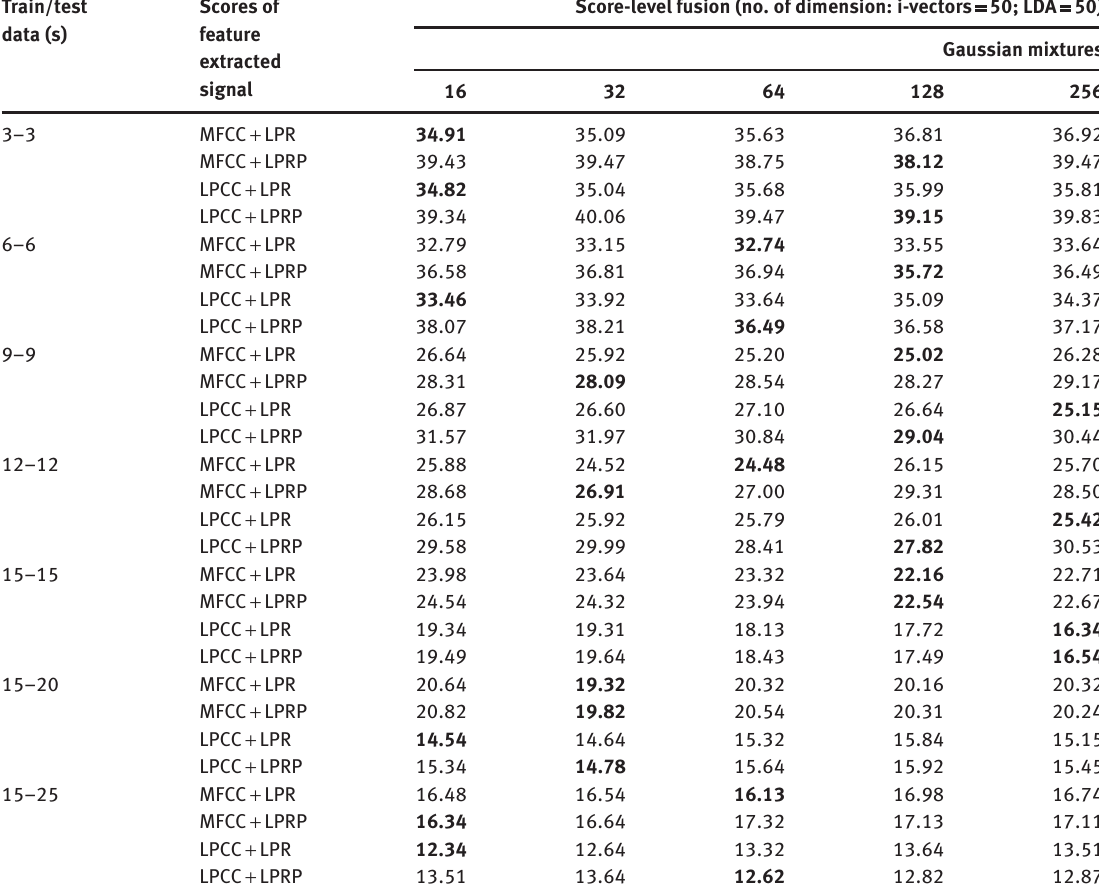
Table 8: Results of the i-Vectors System using Score-Level Fusion of the Vocal Tract and Excitation Source Features (13 Dimen- sion) for Limited Data Condition on NIST 2003